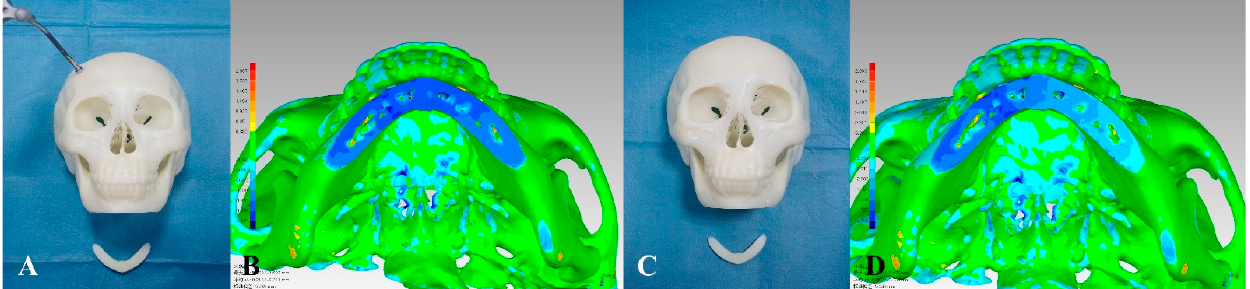
Figure 6. Surgical outcomes. Experimental group: ( A ) Actual osteotomy. ( B ) Image fusion showed the comparison of mandibular osteotomies between the postoperative CT and VSP. Control group: ( C ) Actual osteotomy. ( D ) Image fusion showed the comparison of mandibular osteotomies between the postoperative CT and VSP. Table 1. The operative results.